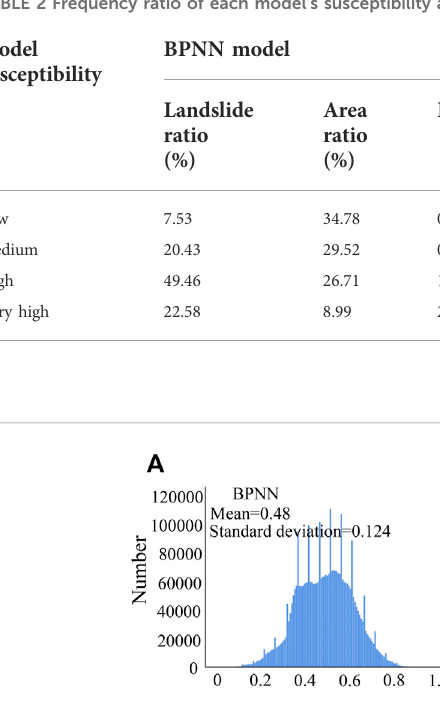
TABLE 2 Frequency ratio of each model ’ s susceptibility area.